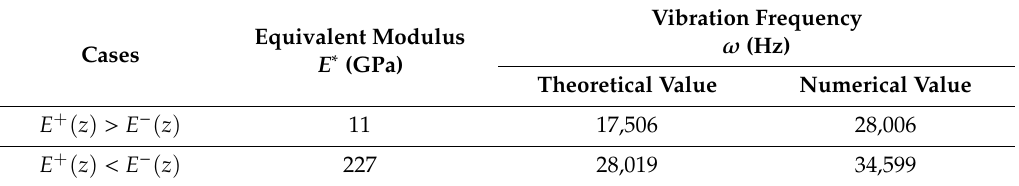
Table 6. Equivalent modulus and frequency from theoretical and numerical